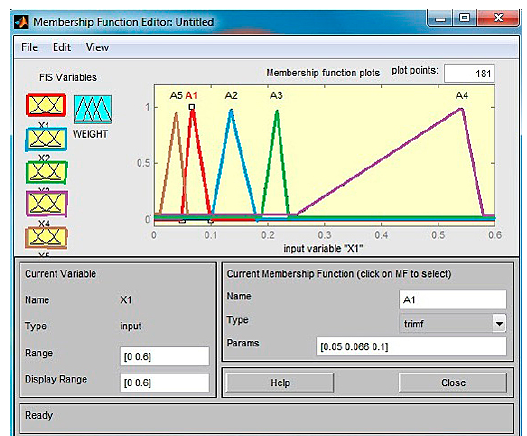
fig. 4. The fuzzy membership functions of the input